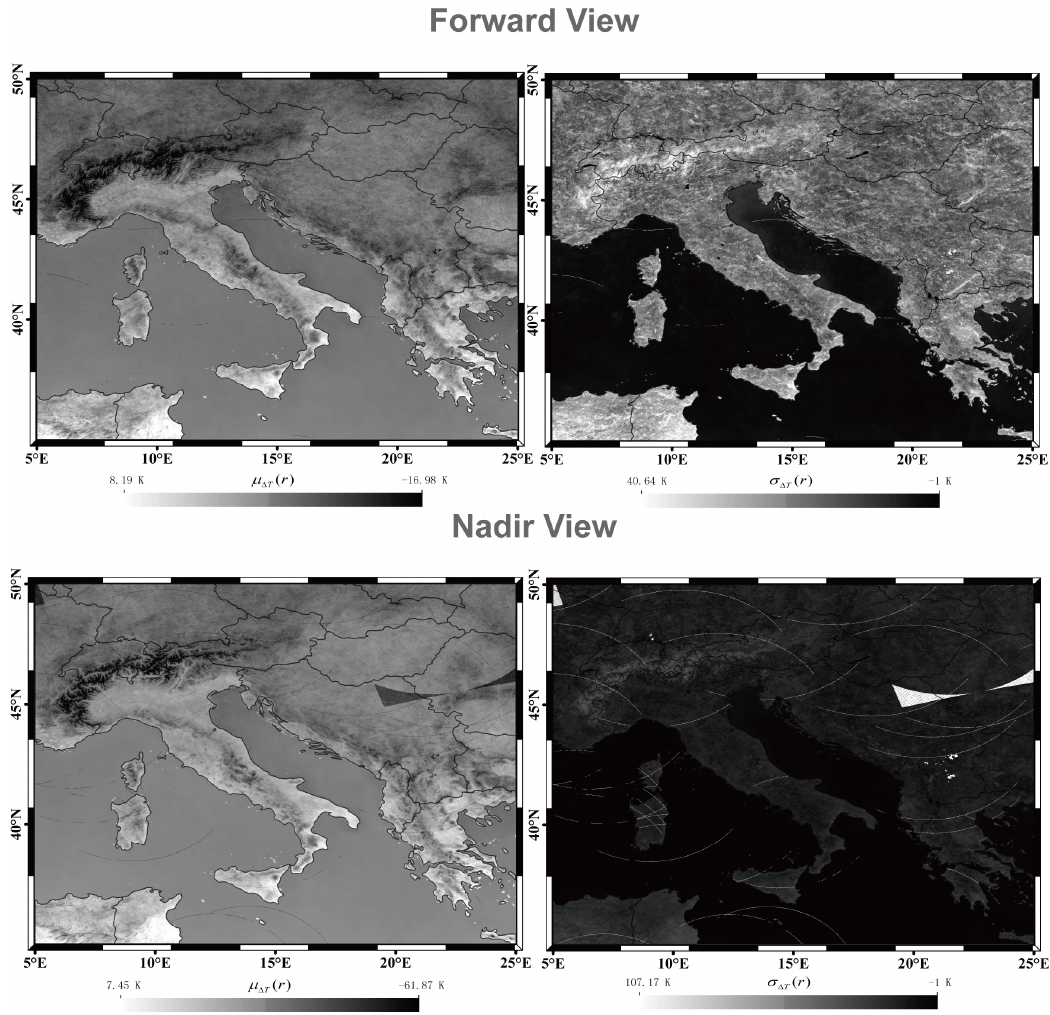
Fig. 3. The mean (left panels) and the standard deviation (right panels) of the reference fields for the investigated area of forward view and Figure 3. The mean (left panel) and the standard deviation (right panel) of the reference fields 2 nadir view computed from bi-angular AATSR data from 2003 to 2009 during the months of for the investigated area of forward view and nadir view computed from bi-angular AATSR 3 data from 2003 to 2009 during the months of March. 4